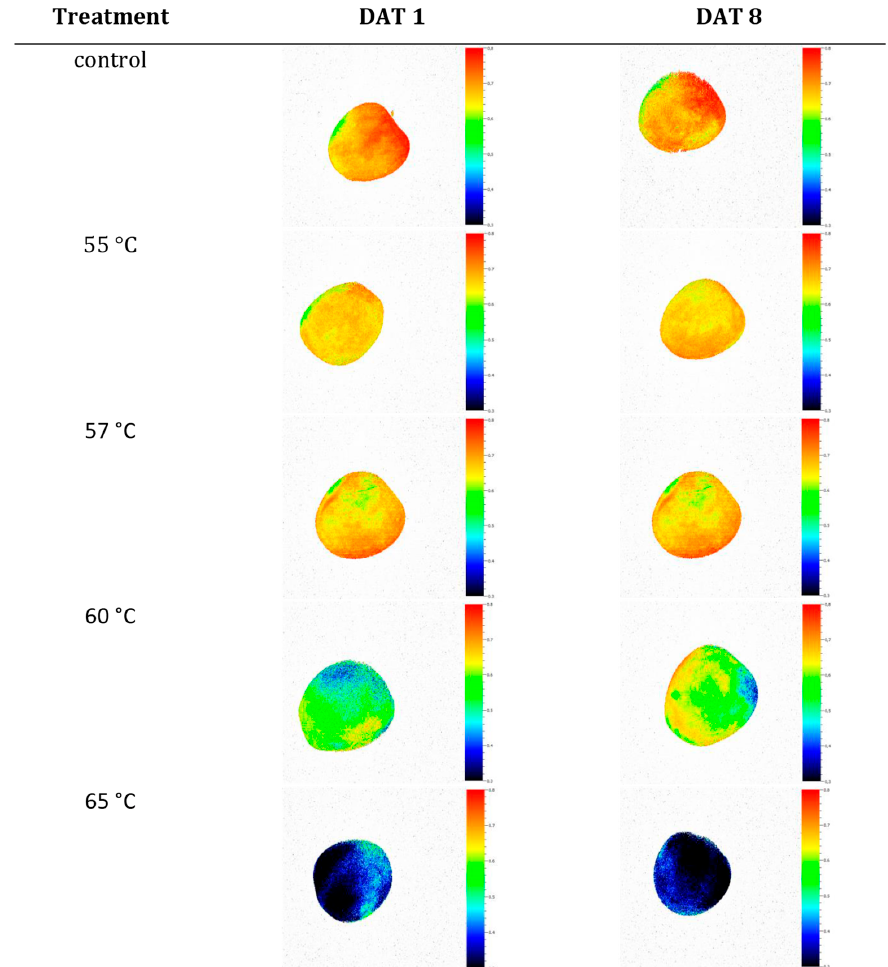
Figure 5. Local variations of the potential maximum photon yield of PSII (F v/ F m ) of ‘Braeburn’ apples, hot ‐ water ‐ treated at temperatures ranging from 55 to 65 °C for 30 s. Measurements were performed 1 or 8 d after treatments (DAT). Controls were not treated. After HWT and between measurements, all samples were stored at 4 °C.